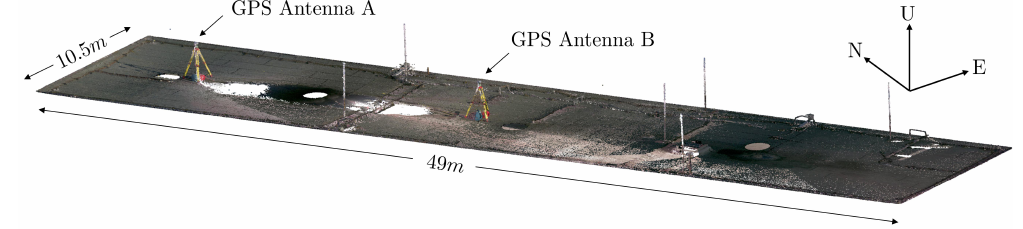
Figure 16. Colored point cloud of the building roof and the positions of GPS antennas A and